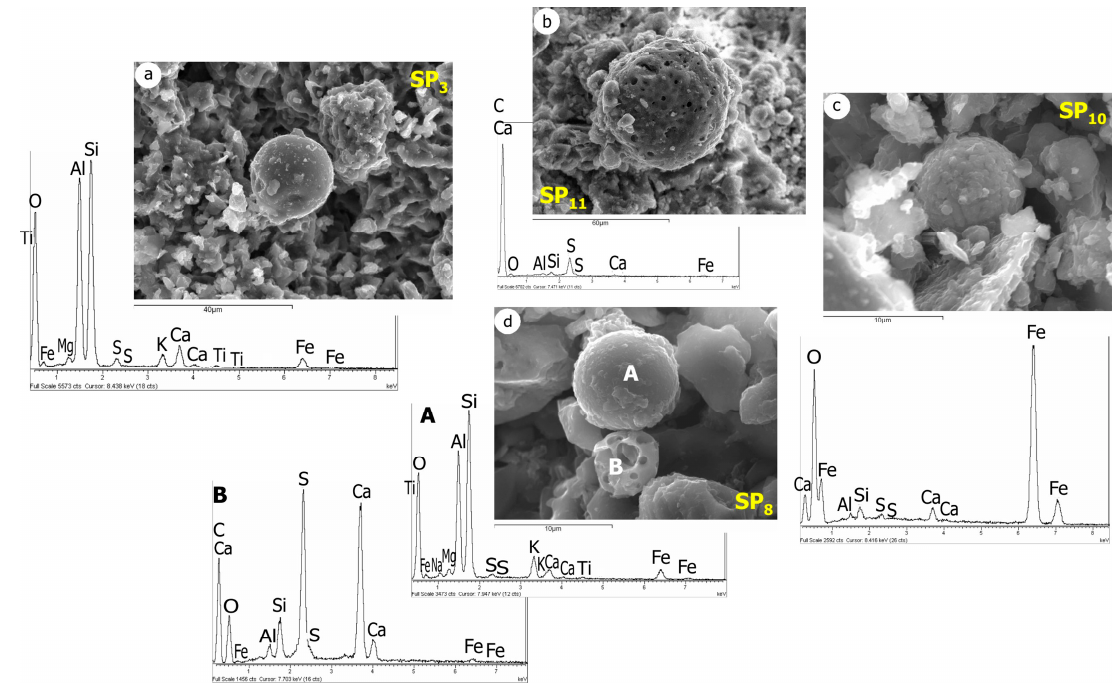
Figure 7. Main typologies of spheres associated with anthropic pollution in the vicinity of the former hospital and identified on blackened limestone: ( a ) smooth, compact Al- and Si-rich spheres; ( b ) carbonaceous porous spheres and/or spheres with high S and Ca contents; ( c ) smooth, compact Fe spheres; ( d ) ( A ) smooth and compact Al-/Si-rich spheres and ( B ) sphere with high S and Ca contents.